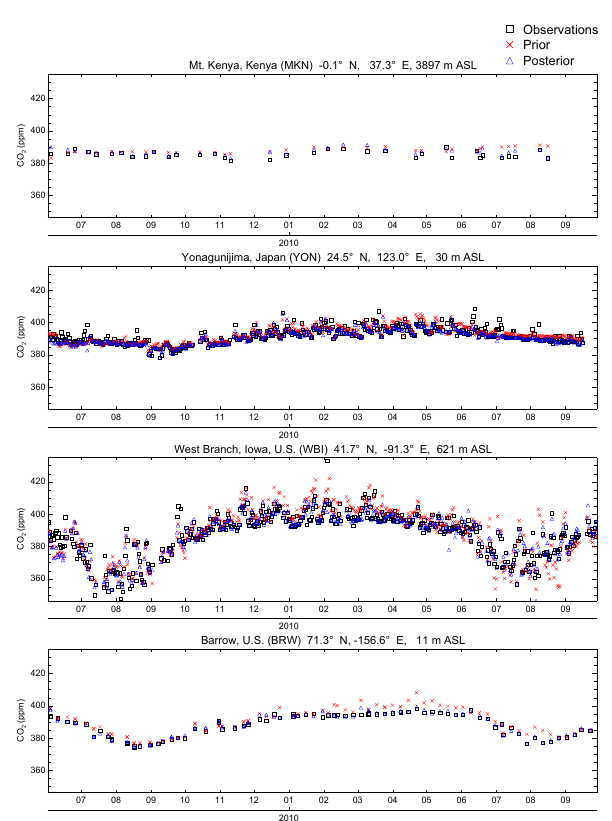
Figure 2. Comparison of model and observed time series of CO 2 mole fractions at selected surface sites. Posterior mole fractions are for the in situ only inversion. Sites are arranged from south to north. The elevation for the West Branch, Iowa (WBI) site includes the intake height on the